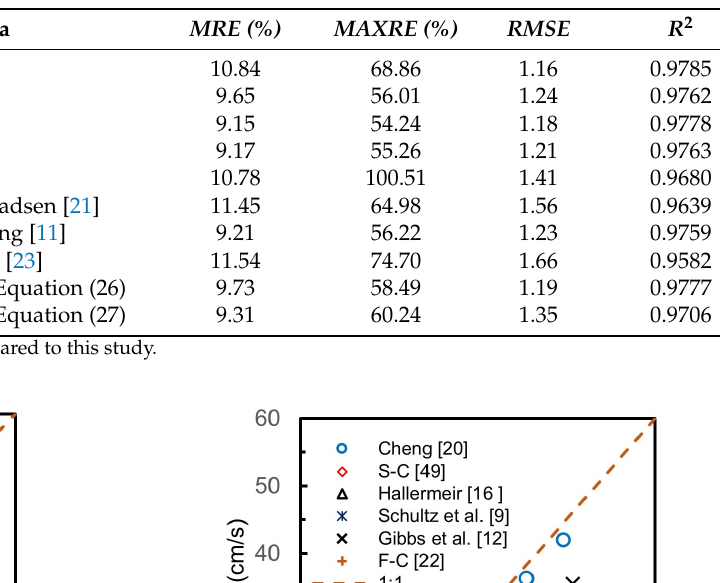
Table 10. Statistical measures for ANN1 to ANN5 as well as existing equations and ANN4 Equation (26) and ANN5 Equation (27) for testing 2.